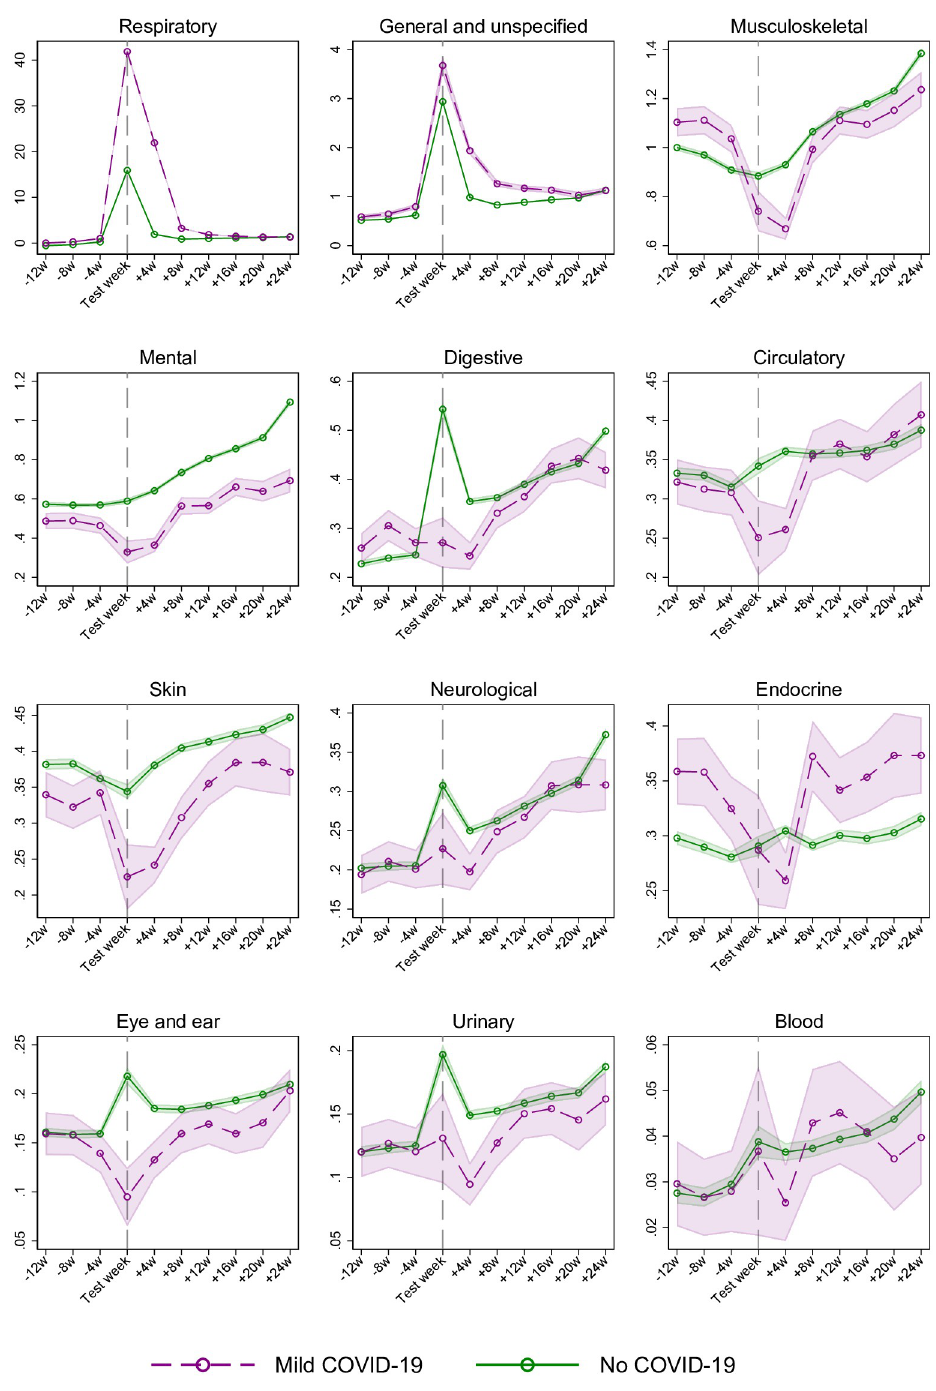
Fig 2. Estimated percent (95% CI) of women and men using primary care in a week, from 3 months before to 6 months after week of PCR test for SARS-CoV-2, for persons with mild COVID-19 and no COVID-19, by cause- specific diagnosis groups. Estimates adjusted for age, sex, comorbidities, birth country and calendar month. The cause-specific diagnosis conditions are ordered by decreasing percentage of primary care.